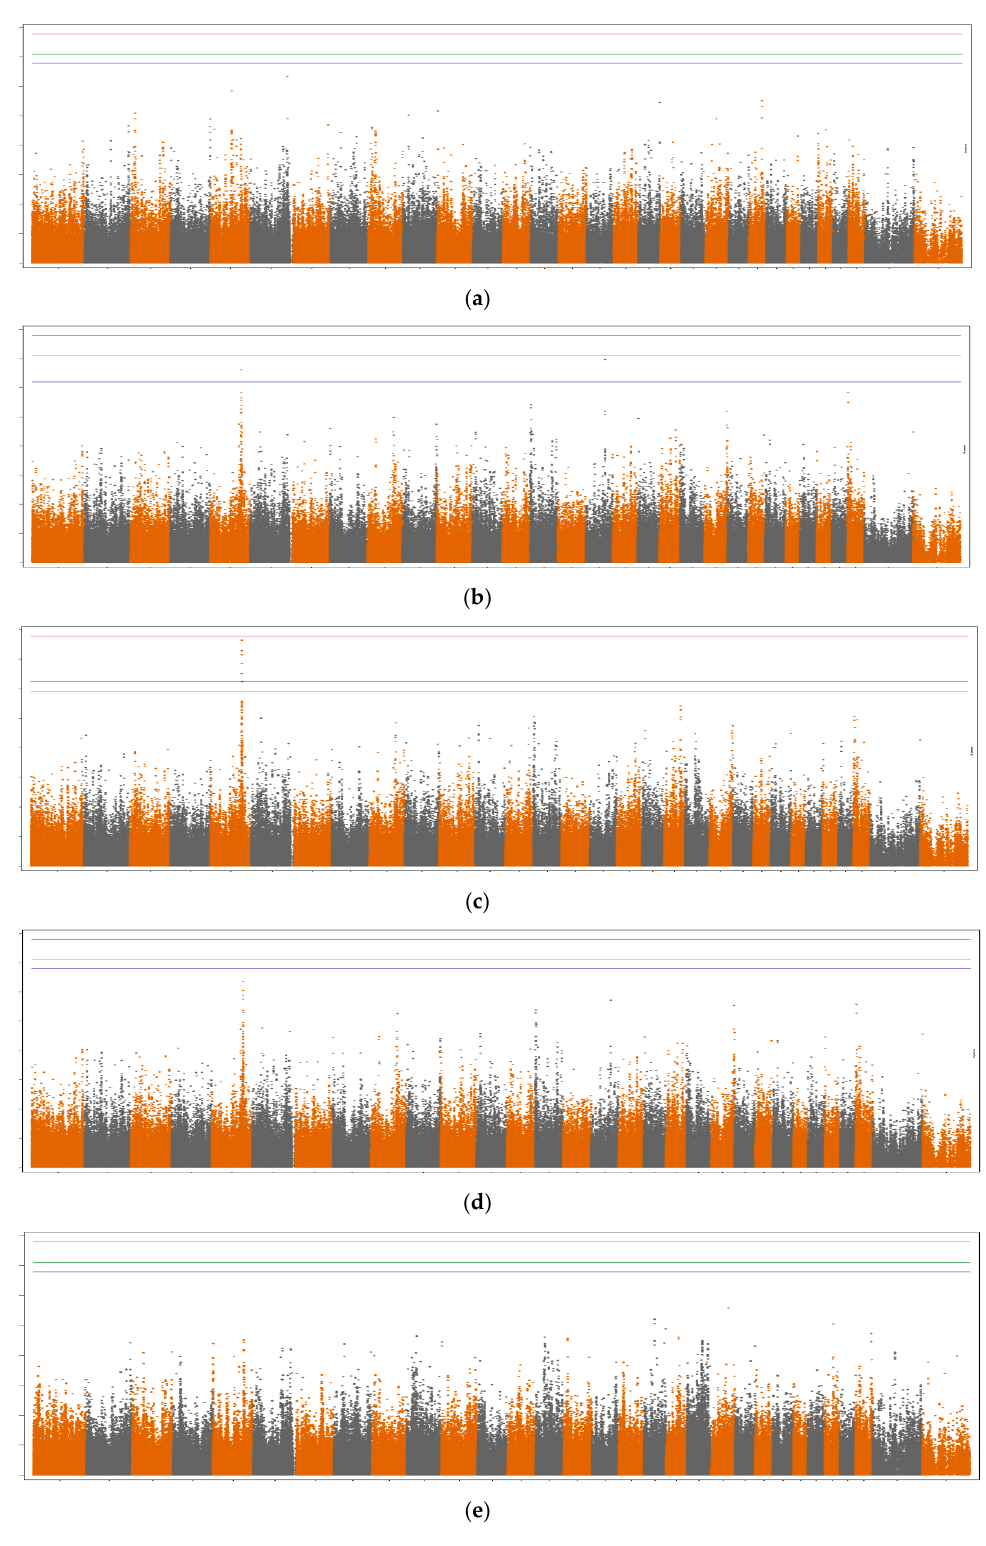
Figure 2. Manhattan plots for the di ff erent fatty acid groups (i.e., long-chain ( a ), medium-chain ( b ), short-chain ( c ), saturated ( d ), and unsaturated ( e ) fatty acids), when fitting the DGAT1 gene as a covariate in the statistical model. Genome-wide plots show the -log10 (I-values) in the y-axis and the chromosome number in the x-axis. Lines represent chromosome-wise FDR thresholds of 10% (blue), 5% (green), and 1%